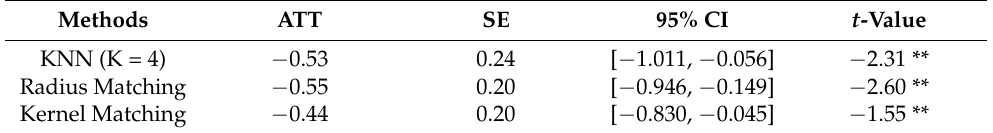
Table 4. Propensity Score Matching results.